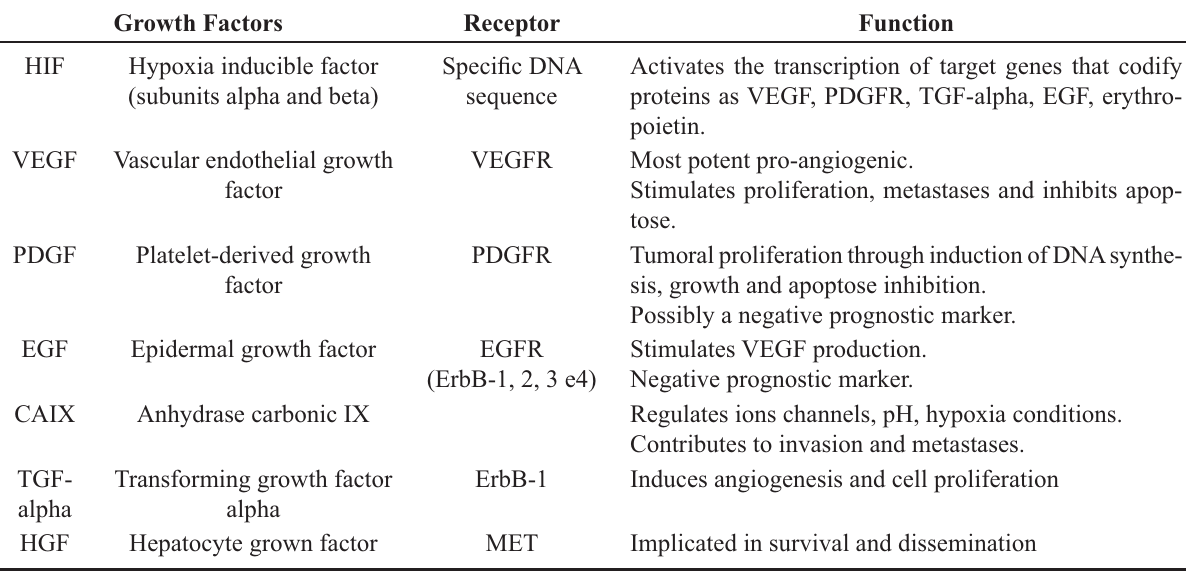
Table 1 - Growth factors related to target therapies in renal cancer management.